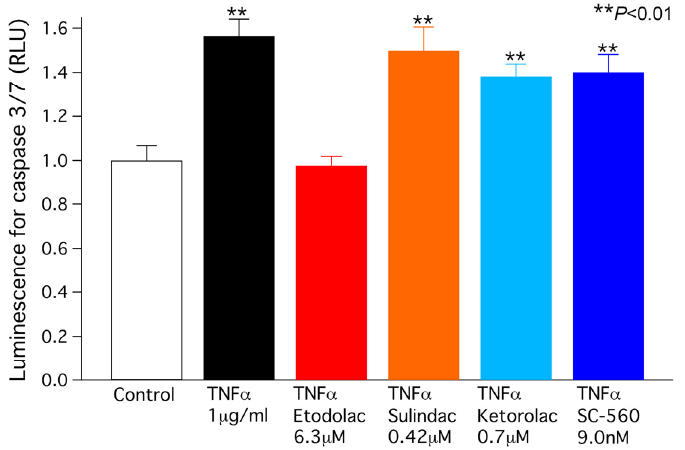
Figure 4. Caspase-3/7 activity, measured in chondrocytes after a 48-h exposure to TNF- α (1 μ g/mL) without or with the COX-2 inhibitor etodolac and the COX-1 inhibitors sulindac, ketorolac and SC-560. Asterisks represent p values according to the Newman-Keuls multiple means comparison test ( ** p <